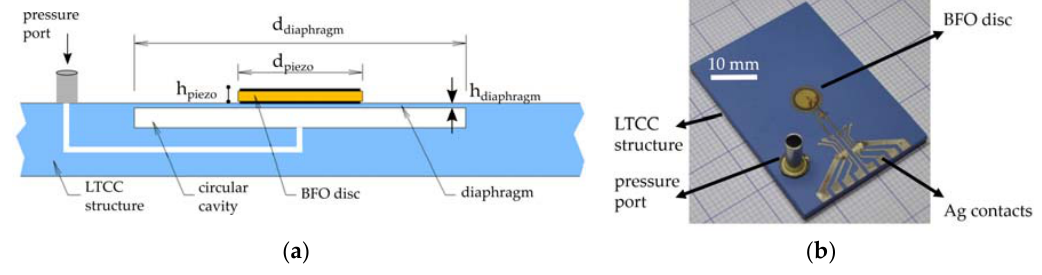
Figure 1. Construction of the pressure sensor; ( a ) schematic cross ‐ section of the sensor’s structure and ( b ) photograph of the actual device. In Figure 1a, the diameter of the diaphragm and BFO disc is marked as d diapragm and d piezo , respectively; the thickness of the diaphragm and BFO disc is marked as h diapragm and h piezo , respectively.